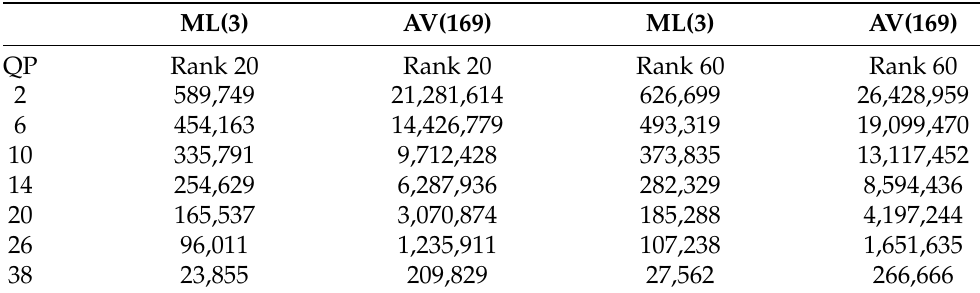
Table 7. Comparison of bytes written to file during compression using proposed scheme with (ML(3)) and without (AV(169)) multiplicative layers. Experiment evaluated on Bikes light field for BK-SVD ranks 20 and 60.